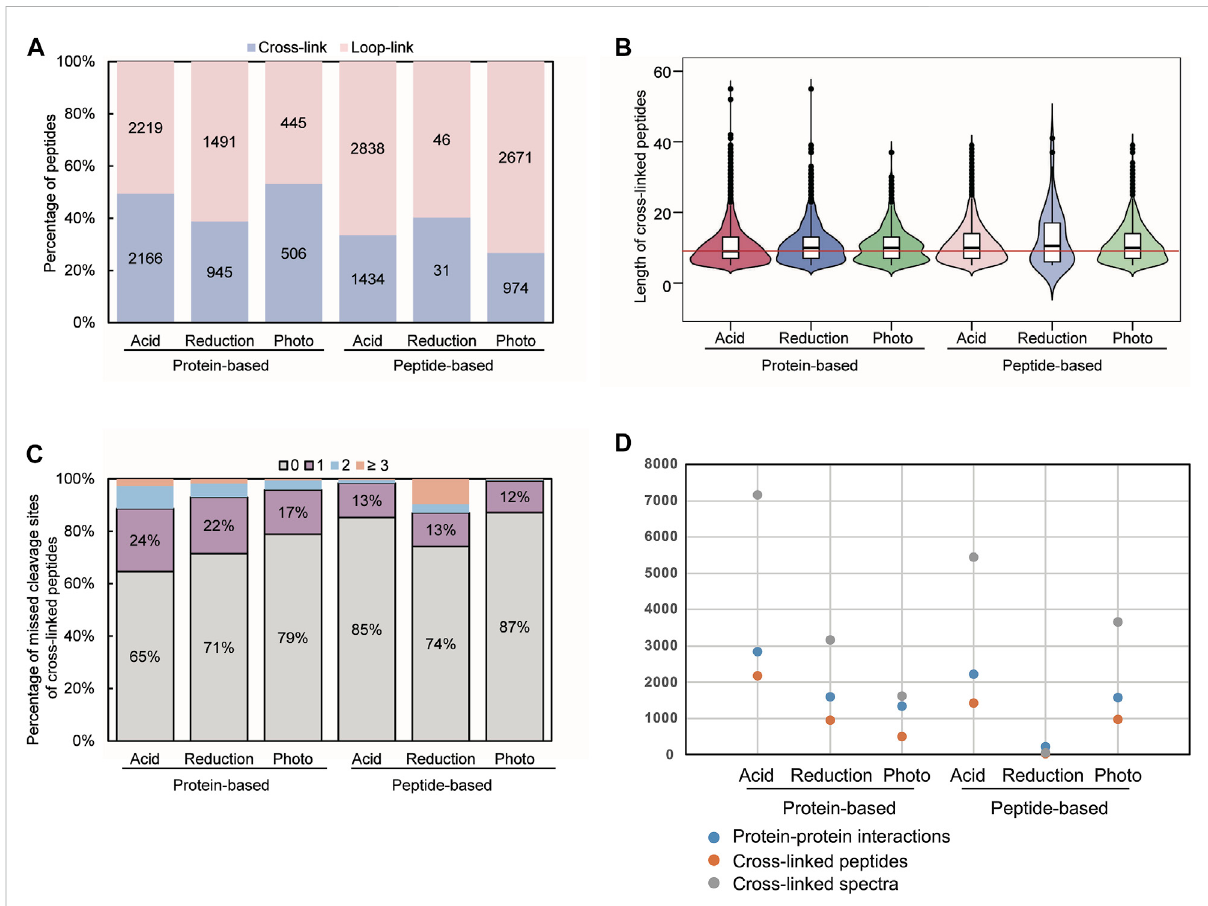
FIGURE 2 Comparison of (A) type proportion, (B) length, and (C) missed cleavage of the cross-linked peptides, as well as (D) number of cross-linked spectra, cross-linked peptides, and protein – protein